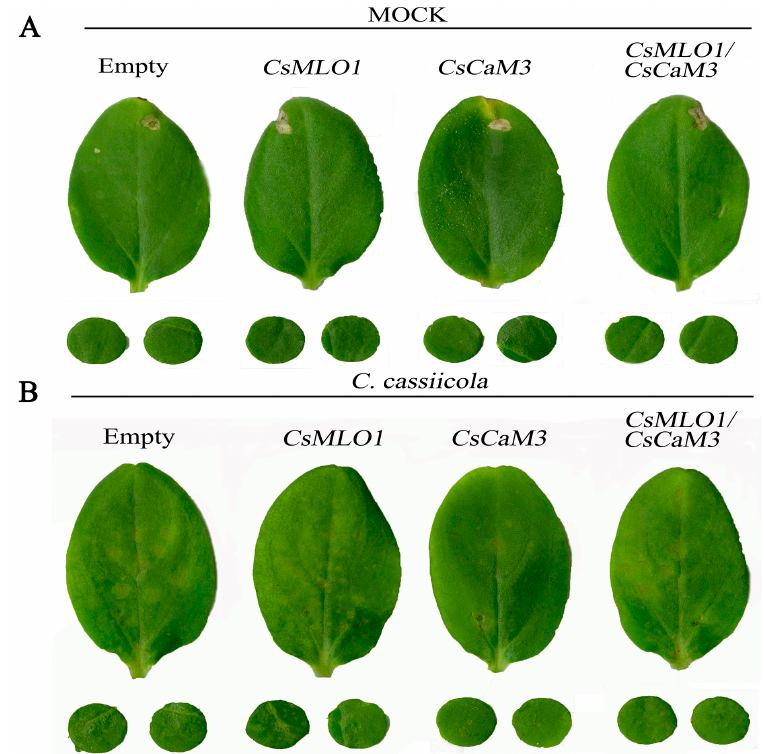
Figure 7. Identification of disease-resistance of empty vector control, CsCaM3 -overexpressing, CsMLO1 -overexpressing, and CsCaM3 -GFP + CsMLO1 -GFP-overexpressing constructs in cucumber cotyledons. ( A ) Phenotype of uninfected cucumber cotyledons. ( B ) Phenotype of cucumber cotyledons after C. cassiicola challenge.